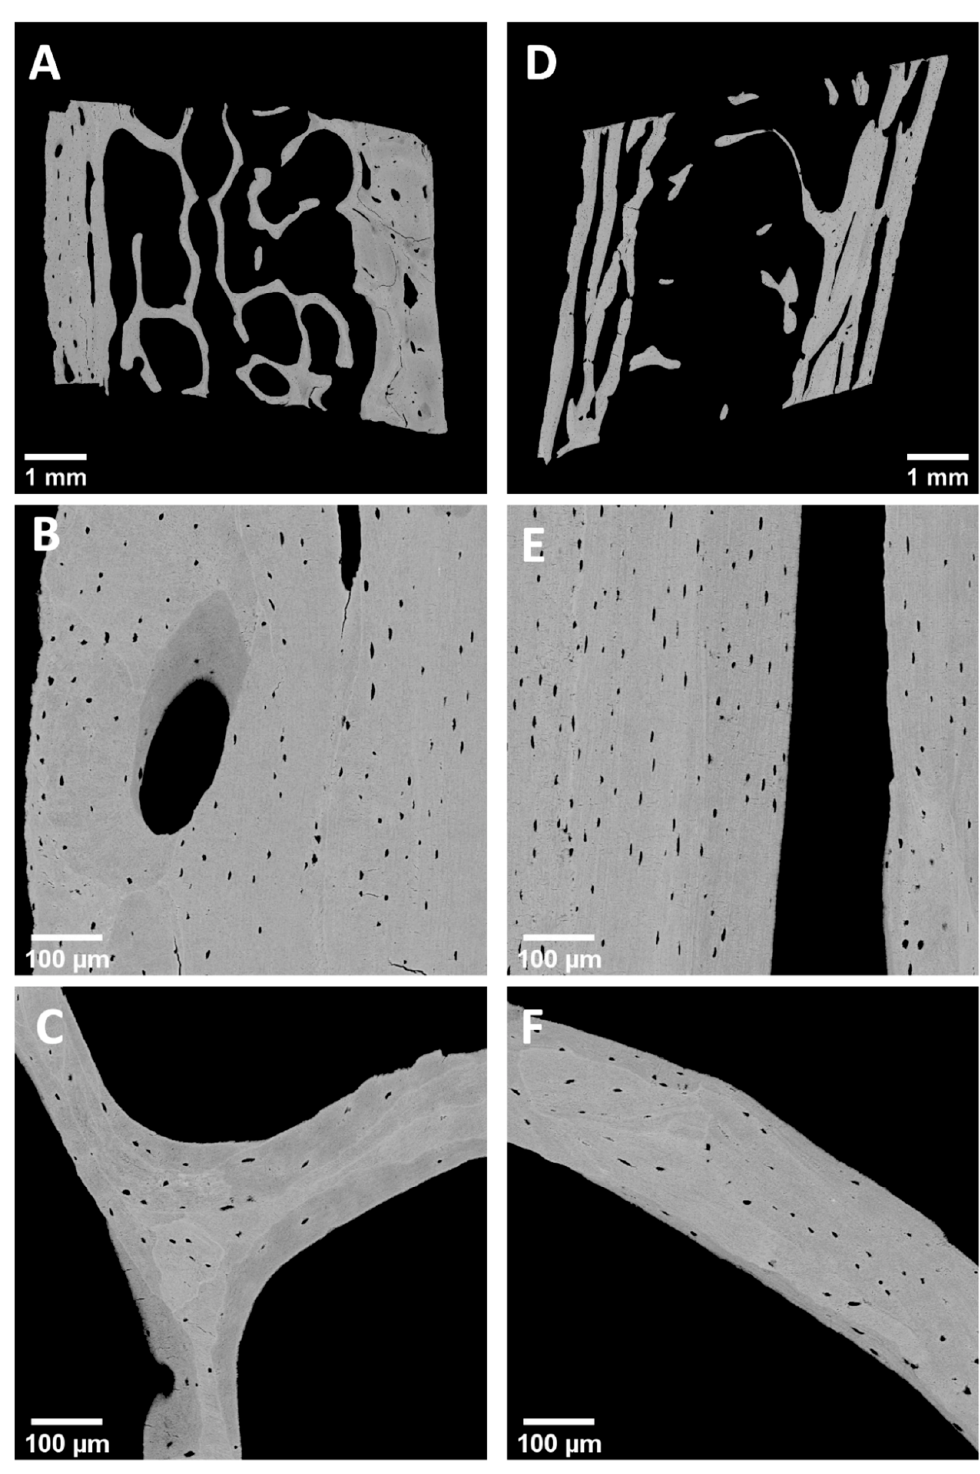
Figure 1. Example of quantitative backscattered images of transiliac bone biopsy samples from healthy children ( A – C ) and children with OI type I ( D – F ). Typical backscattered electron images of a complete biopsy samples ( A ) from a 2-year-old healthy boy and ( D ) from a 7.6-year-old female OI type I patient with qualitative mutation. Note the decreased number and thickness of trabeculae and the decreased cortical width in OI type I bone. Example of quantitative backscattered images used for OLS analysis of cortical bone ( B , E ) and trabecular bone ( C , F ). Note the increased osteocyte lacunar density that can be judged especially in the cortical compartment of OI type I bone ( B versus E ). Nominal magnification: A and D : 65×; B , C , E and F : 130×.